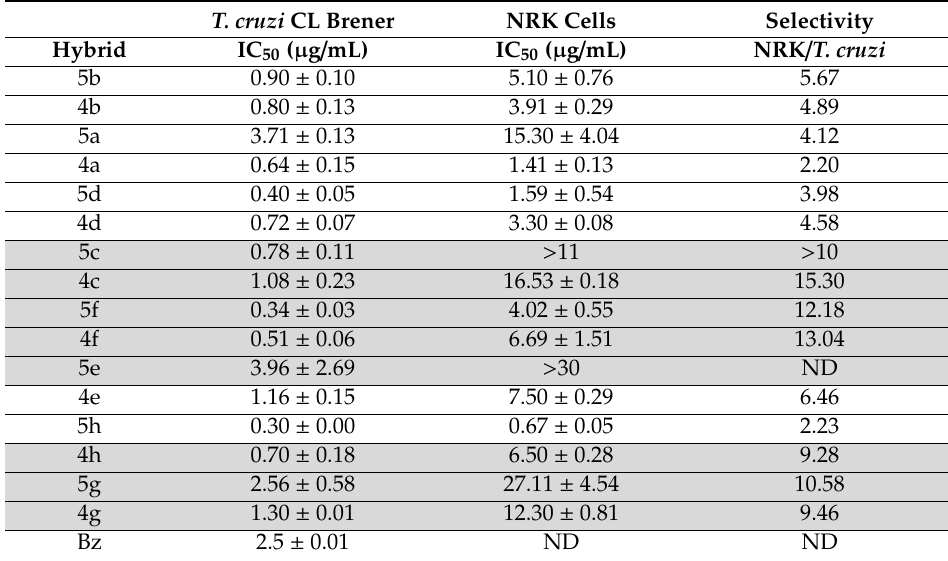
Table 2. IC 50 values for trypomastigotes and NRK cells were determined as described in Materials and Methods. The selectivity index (SI) was calculated as IC 50 NRK / IC 50 parasite. Hybrids with an IC 50 close to 1 µ g / mL and / or a selectivity higher then 10 (in grey) were selected as cytotoxic studies using other strains and for infection assays (see text). ND: Not